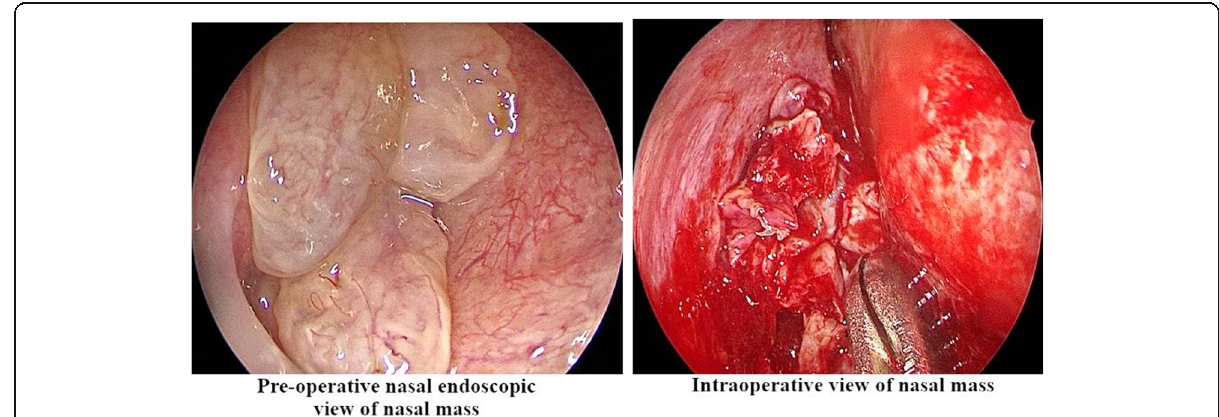
Fig. 3 Pre-operative and intraoperative picture of right-sided nasal